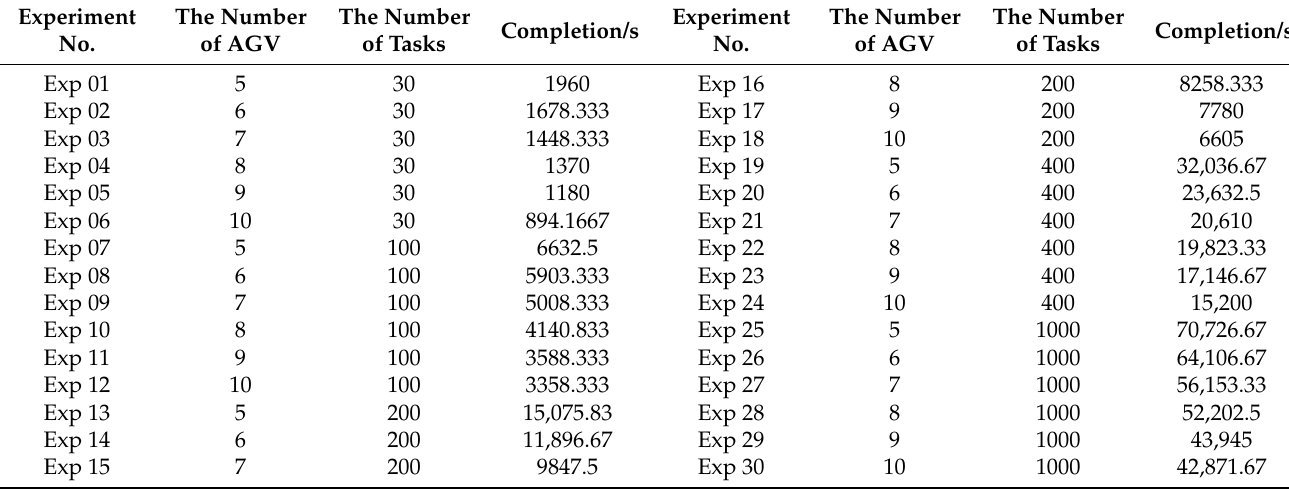
Table 6. Makespan under different container tasks and different AGV quantities.